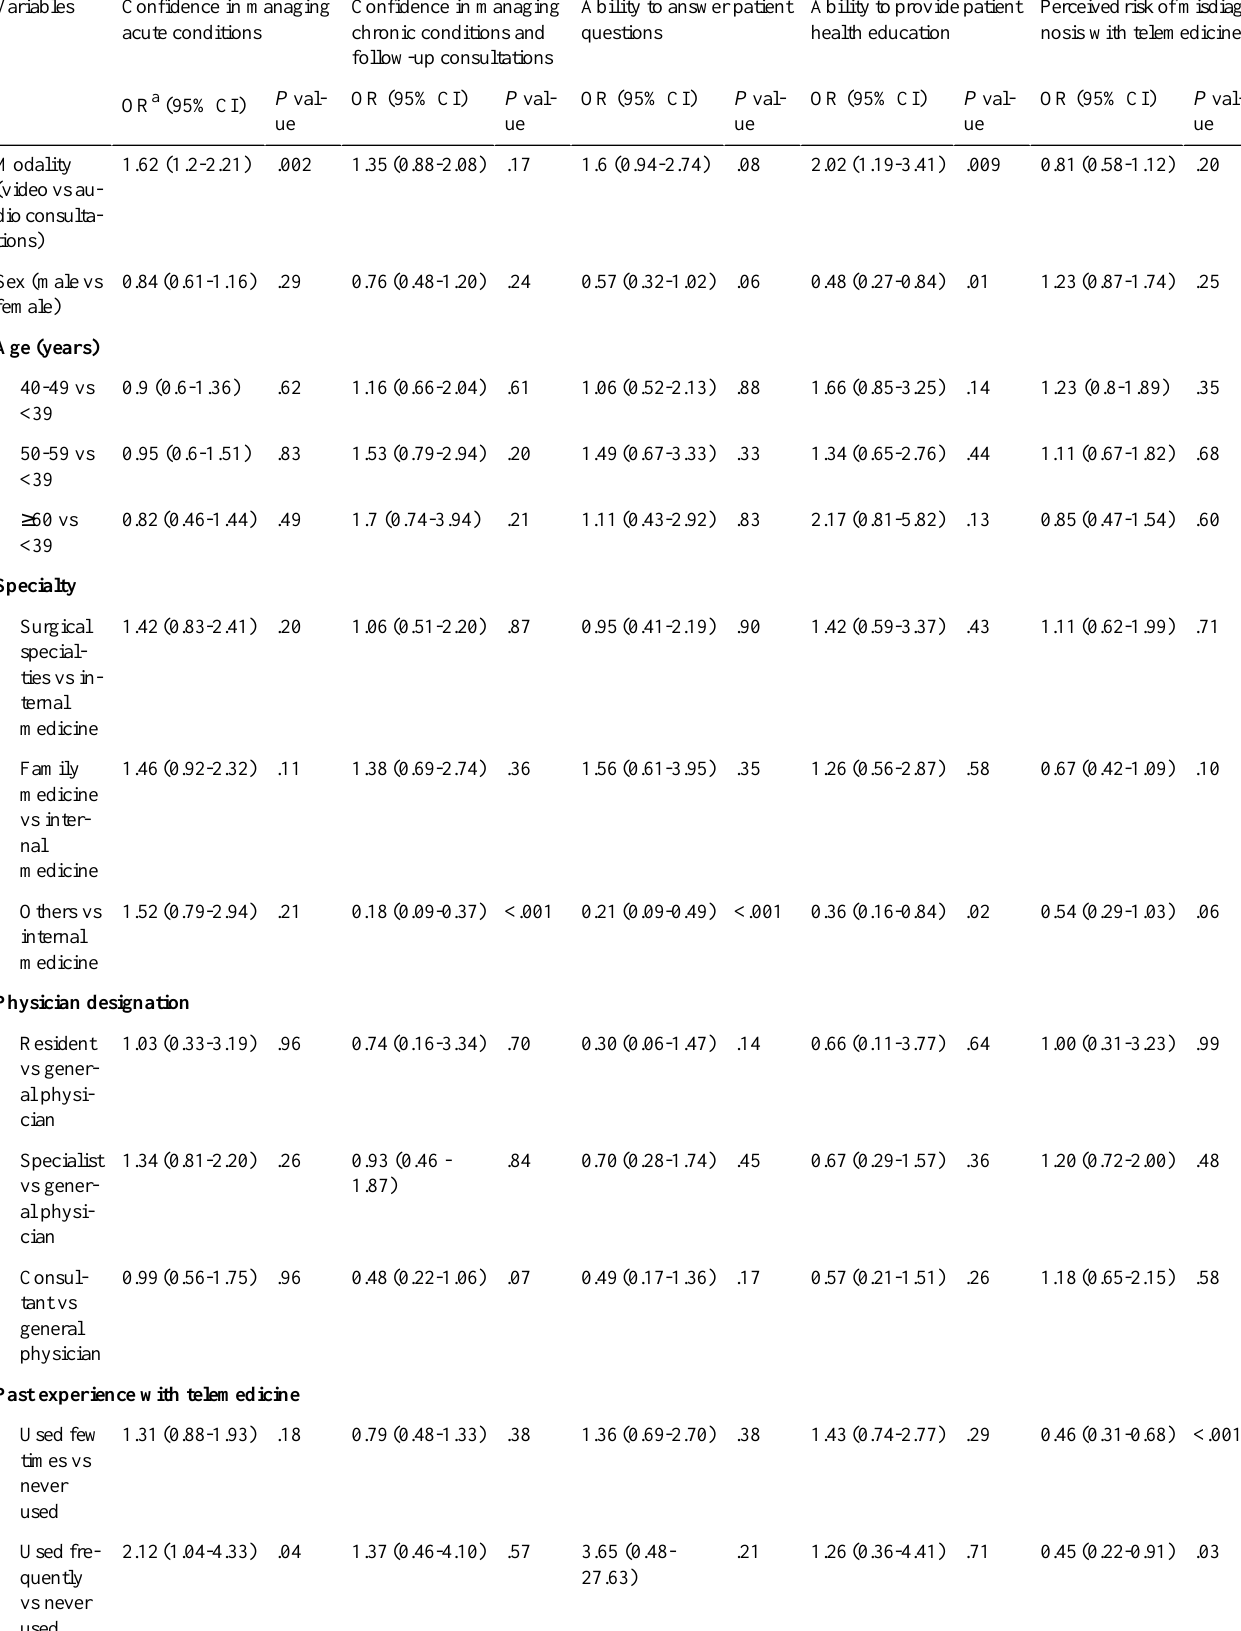
Perceived risk of